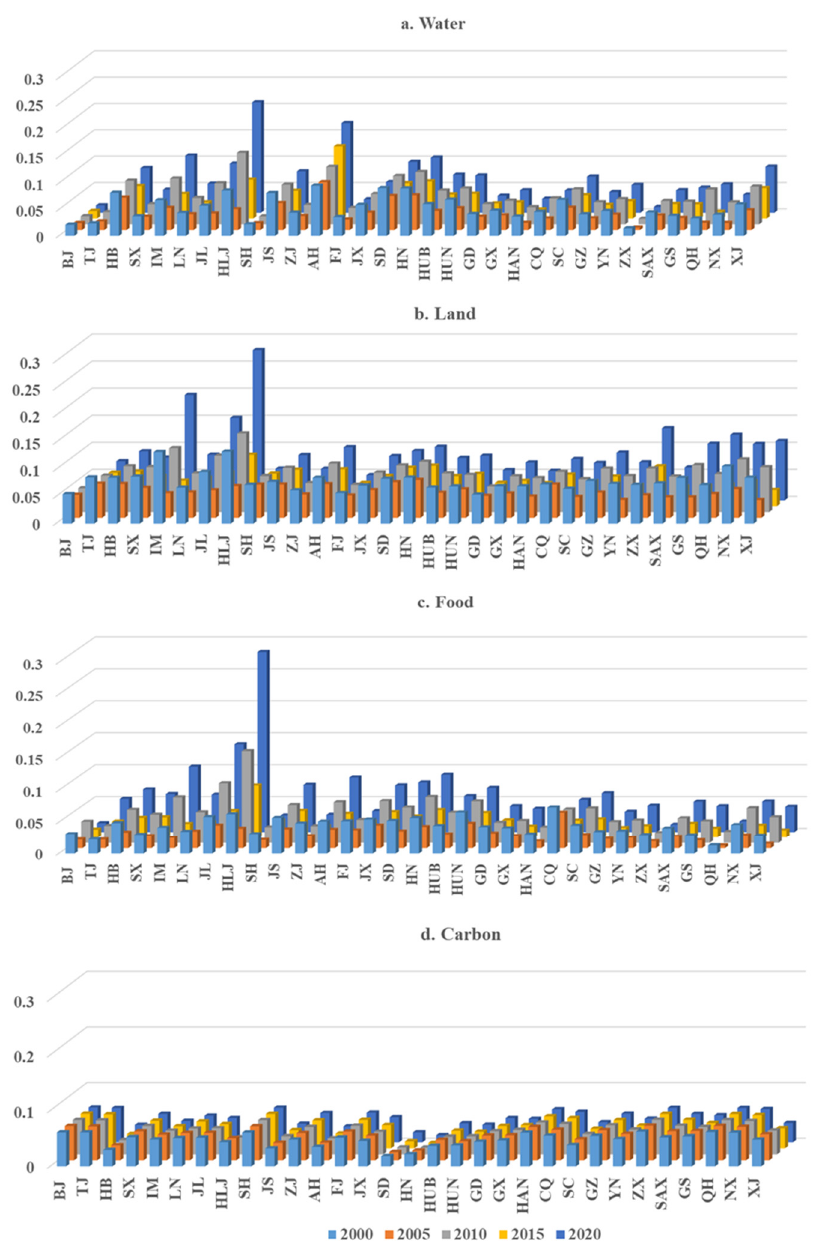
Figure 7. Temporal and spatial distribution of “Water-Land -Food-Carbon”.